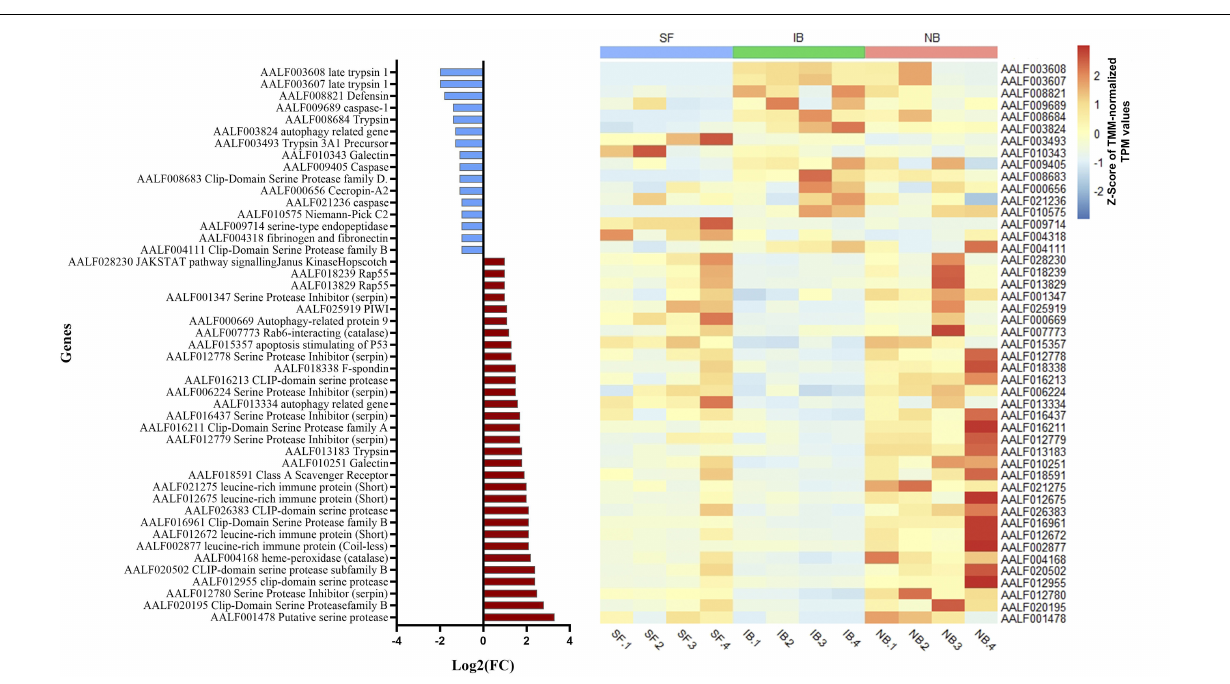
FIGURE 4 | Fold change expression of immune related genes differentially expressed between NB and IB. Upregulated genes (red) and downregulated genes